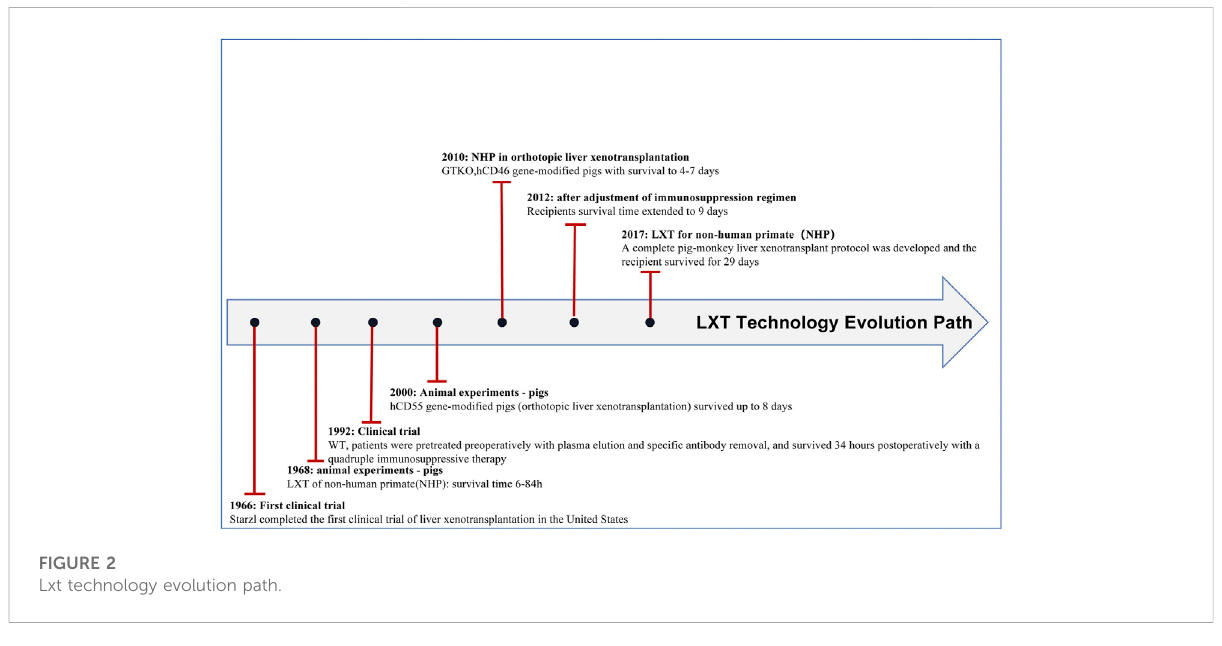
FIGURE 2 Lxt technology evolution path.